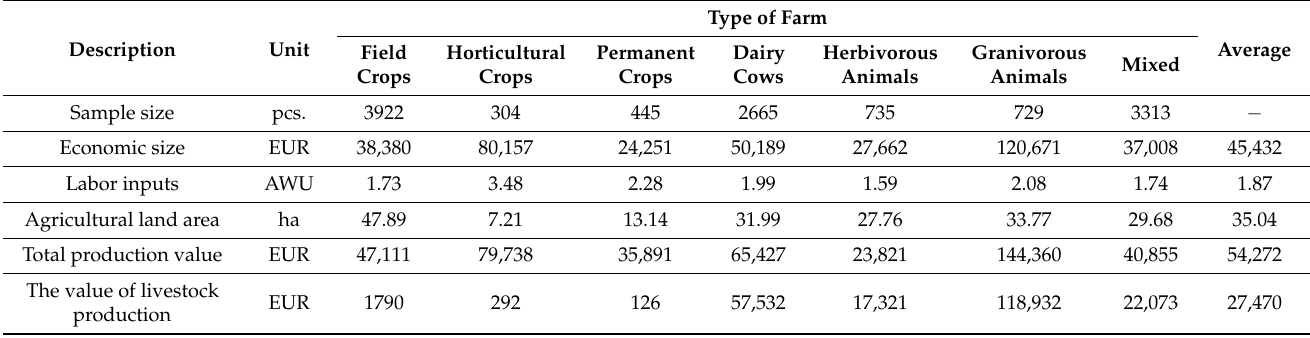
Table 3. Characteristics of the researched